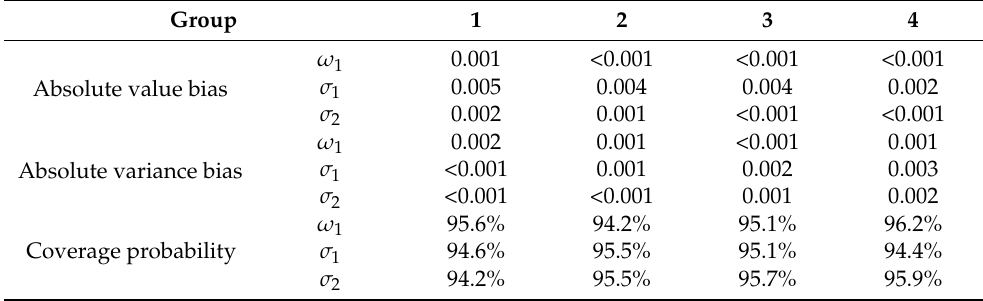
Table 4. False parametric model